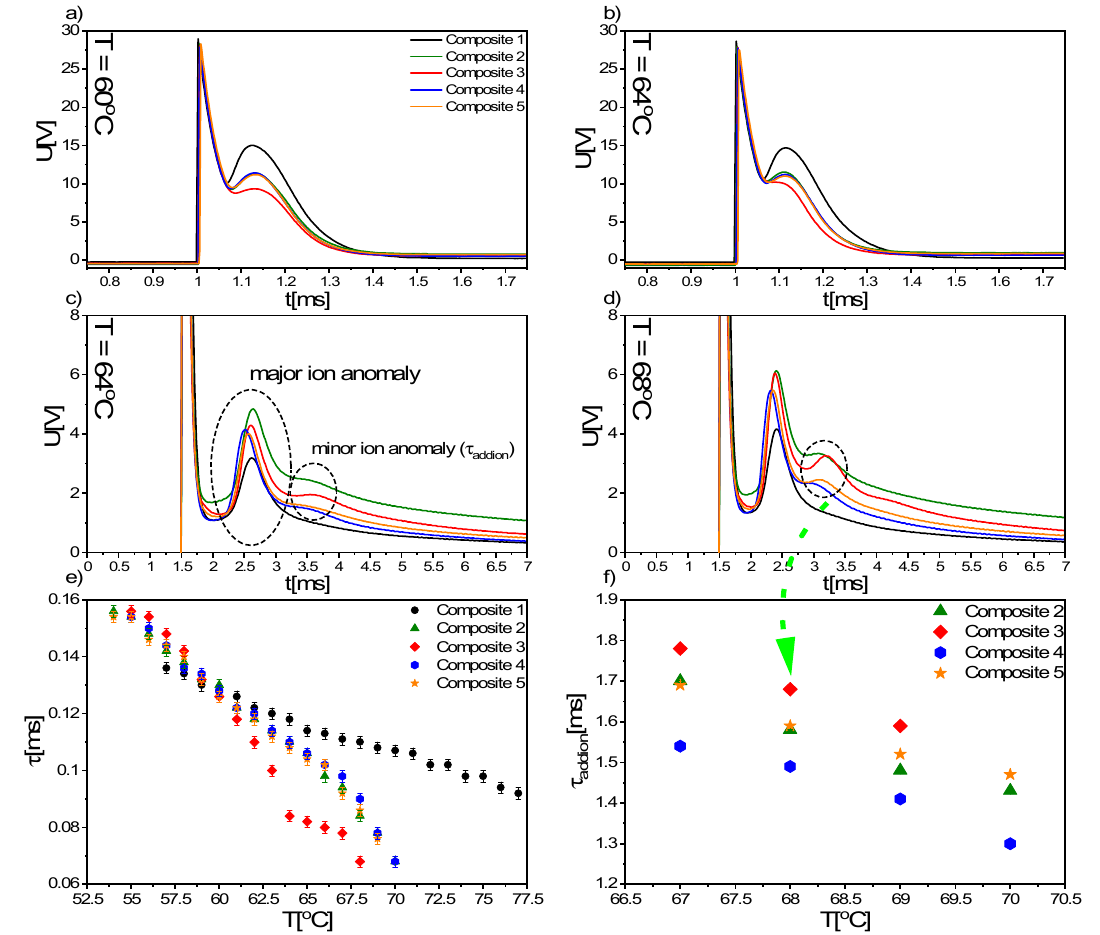
Figure 12. The voltage response of Composites 1–5 on rectangular wave (50 Hz, 20 V pp ) at temperatures of 60 °C ( a ) and 64 °C ( b ), and on rectangular wave (50 Hz, 60 V pp ) at 64 °C ( c ) and 68 °C ( d ). Temperature dependence of the switching time for Composites 1–5 ( e ) and reorientation time of additional ions at several selected temperatures for Composites 2–5 ( f ). The legend in graph ( a ) is the same for ( a – d ) graphs. Based on the switching time and spontaneous polarization measurements, the rota- tional viscosity was determined (Equation (1)), and the results are presented in Figure 13. (cid:4666)(cid:1846)(cid:4667)(cid:1847) (cid:3028)(cid:3043)(cid:3043)(cid:3039)(cid:3036)(cid:3032)(cid:3031) (cid:4666)(cid:1846)(cid:4667)(cid:1831) (cid:2011)(cid:4666)(cid:1846)(cid:4667) = (cid:2028)(cid:4666)(cid:1846)(cid:4667)(cid:1842) (cid:2028)(cid:4666)(cid:1846)(cid:4667)(cid:1842) (1) (cid:3046) (cid:3028)(cid:3043)(cid:3043)(cid:3039)(cid:3036)(cid:3032)(cid:3031) = (cid:3046) (cid:1856) where γ , τ , P s , E applied , U applied and d are the rotational viscosity, switching time, spontaneous polarization, the electric field, applied AC voltage and sample thickness, respectively. As expected, the rotational viscosity increased with decreasing temperature for Composites 1–5, but due to the decrease of spontaneous polarization and shorter switching time, the rotational viscosity, γ , drastically decreased after doping (Figure 13). γ values are the same for Composites 2 and 4 (0.3 and 0.7 wt.%, respectively), but for Composites 3 and 5 (0.5 and 0.9 wt.%, respectively), they are smaller, within the measurement uncertainty. Alt- hough Goel et al. explained the decrease in the rotational viscosity in studied composites (Ni ca. 34 nm, KCFLC7S matrix) by nanoparticles’ adsorption to the ITO surface and mod- ification of anchoring energy of molecules [76], we do not fully understand this behavior